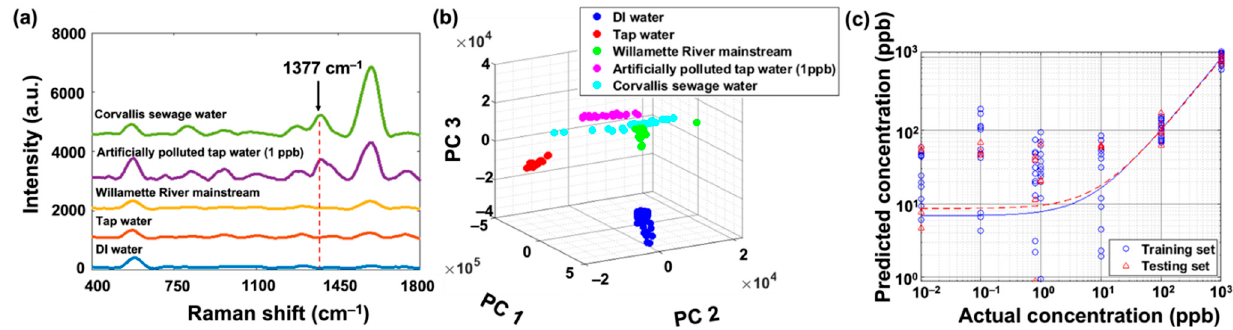
Figure 3. The analytical results of SERS sensing: ( a ) the representative spectra of sewage water and other samples; ( b ) PCA results; and ( c ) PLSR analysis results.